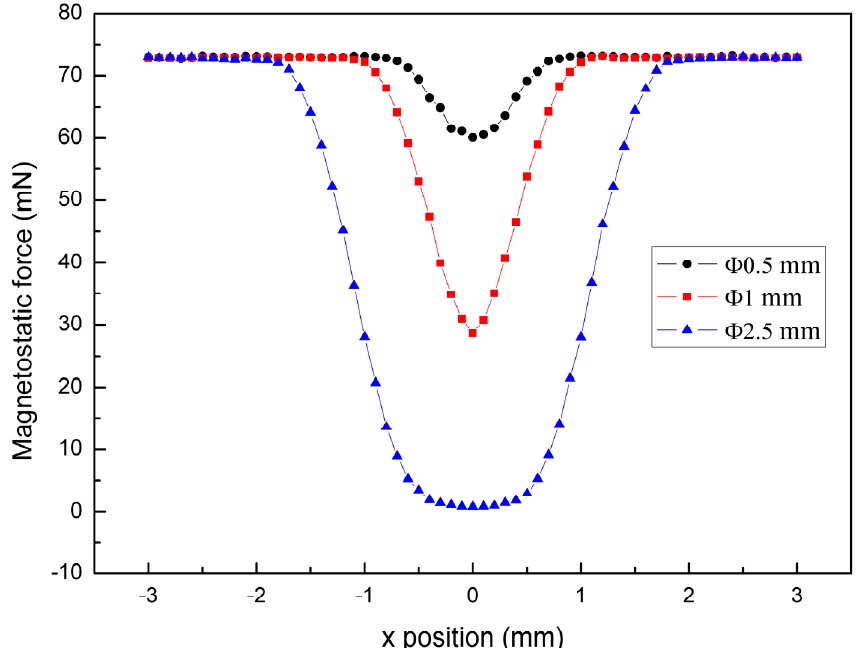
Figure 8. Magnetostatic force calculated by the numerical model.